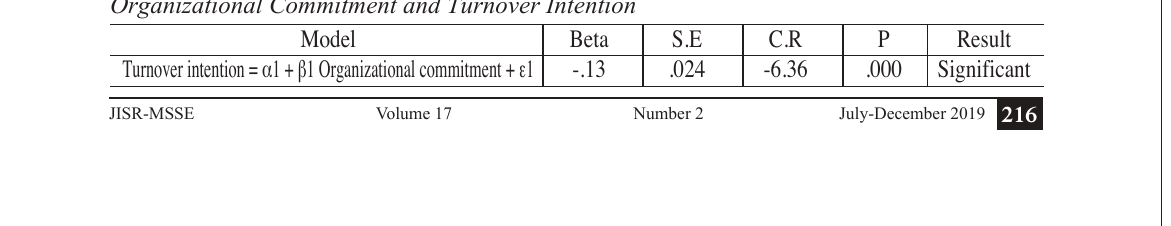
Organizational Commitment and Turnover Intention